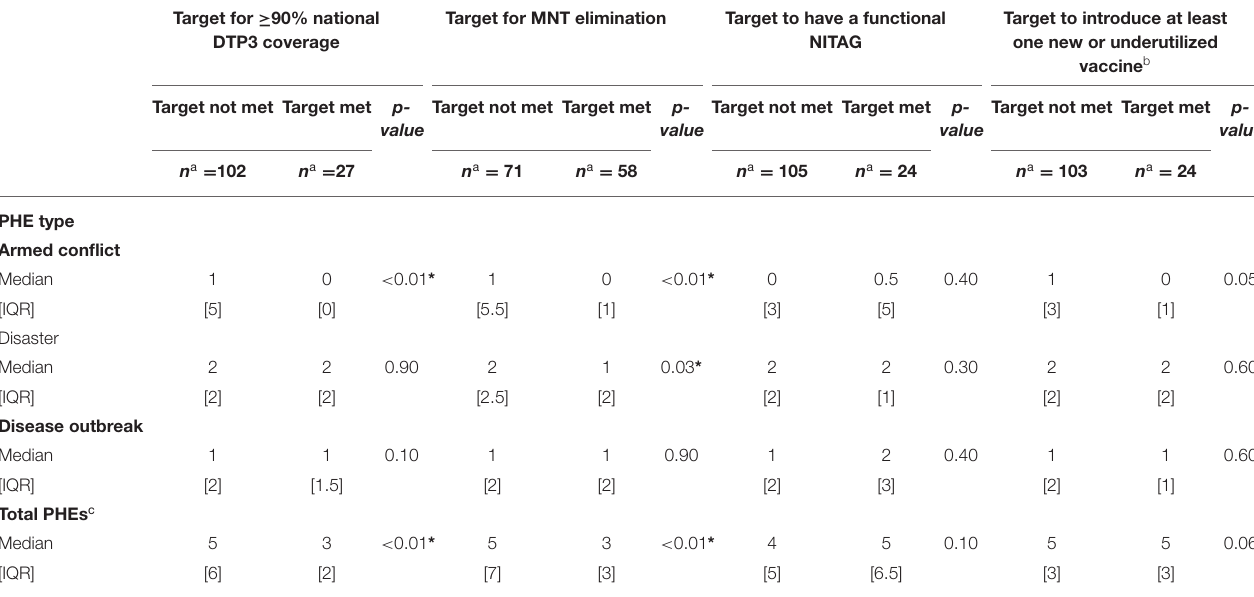
Target to have a functional